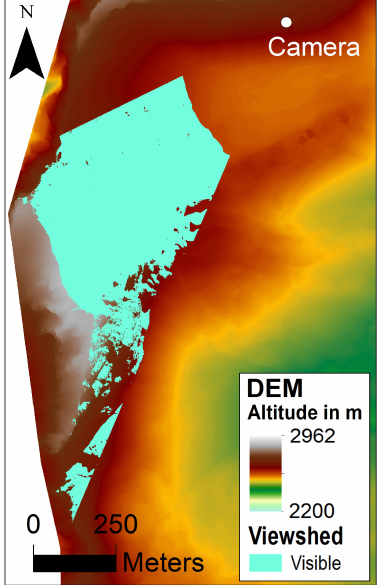
Fig.3. TheoptionalviewshedfeatureofPRACTISEcomputesthevisiblepixels(cyan)usingthecorresponding Fig. 3. The optional viewshed feature of PRACTISE computes the camera location and orientation. visible pixels (cyan) using the corresponding camera location and orientation.